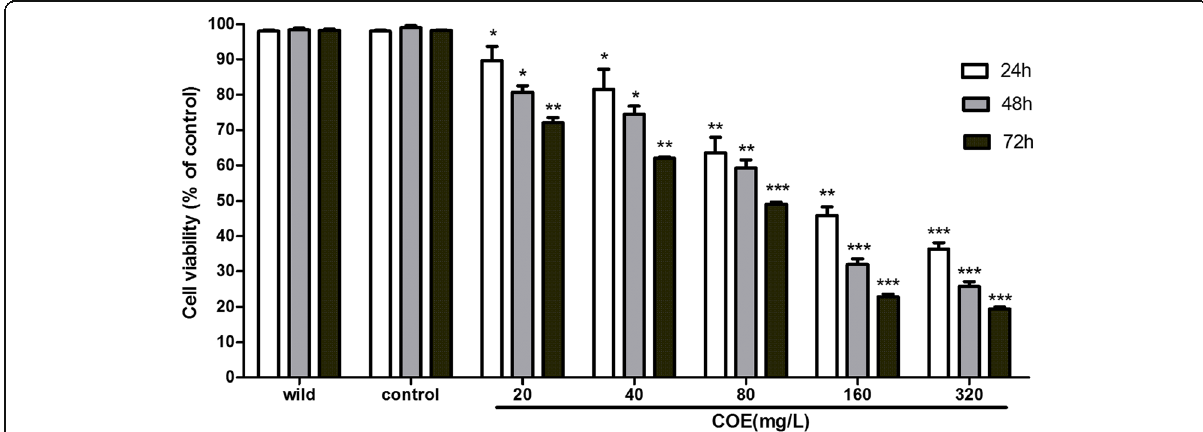
Fig. 2 Effects of COE on the viability of the HCC cells. The HepG2/mTOR + cells were treated with either 0.1%DMSO as solvent control or different concentrations of COE (20, 40, 80, 160, and 320 mg/L) for 24, 48, and 72 h, respectively, and the cell viability was evaluated with MTT assay. ( * P < 0.05, ** P < 0.01, *** P < 0.001, compared with the solvent